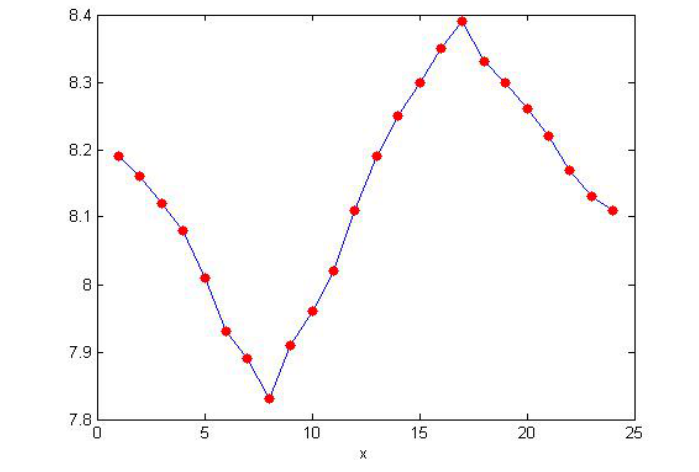
Figure 23. Curve of daily pH changes monitored by the system.